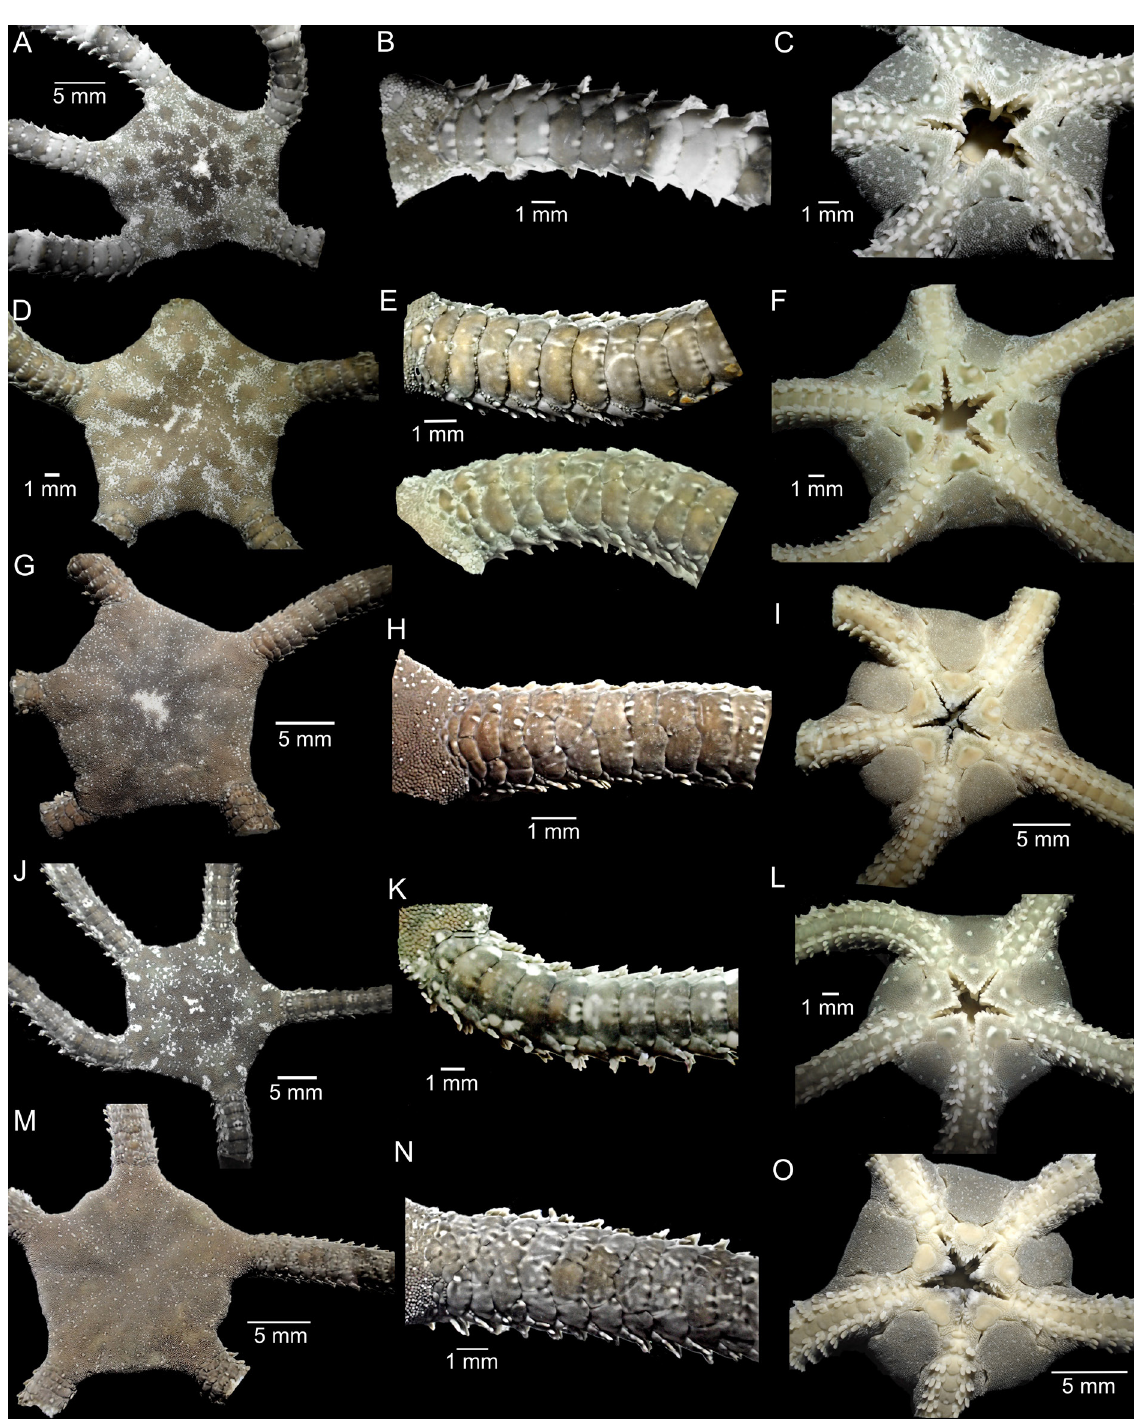
Fig. 10. Colour variation and numbers of dorsal arm plates (DAP) in Ophioderma hybrida sp. nov., digital images. Right column shows dorsal disc, middle column shows dorsal arm, left column shows ventral disc. A – F . Paratypes from Tunisia, Monastir (SMNH-Type-9187). A – C . MON17, single DAPs. D – F . MON16, one arm with 1–2 DAPs, other arm with ≥ 2 DAPs. – G – O . Paratypes from Tunisia, Kelibia (SMNH-Type-9186). G – I . KEL5, ≥ 2 DAPs. J – L . KEL10, single DAPs. M – O . KEL12, ≥ 2 DAPs. For specimen data see Table